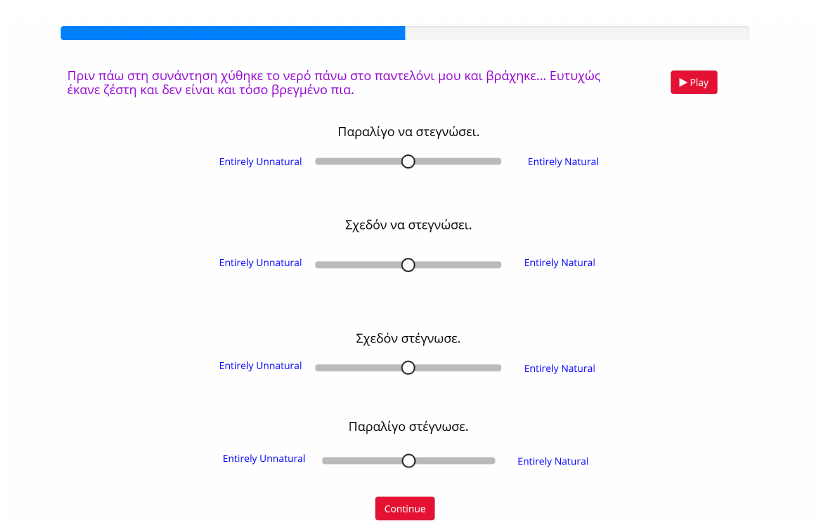
Figure 2. This is an example of what the HSs in USA would see in each experimental trial. The guidelines where presented for each group in the majority language. The context was recorded to facilitate the